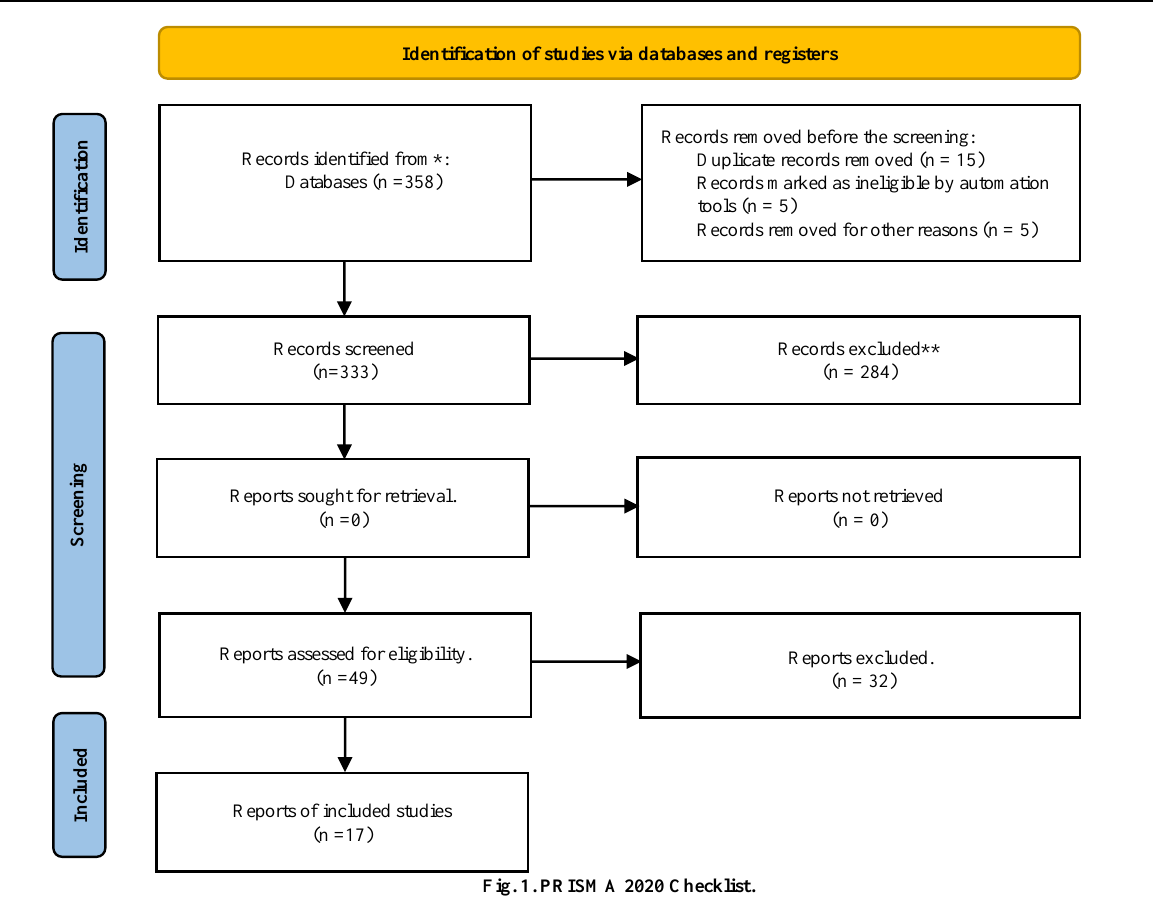
Fig. 1. PRISMA 2020 Checklist.